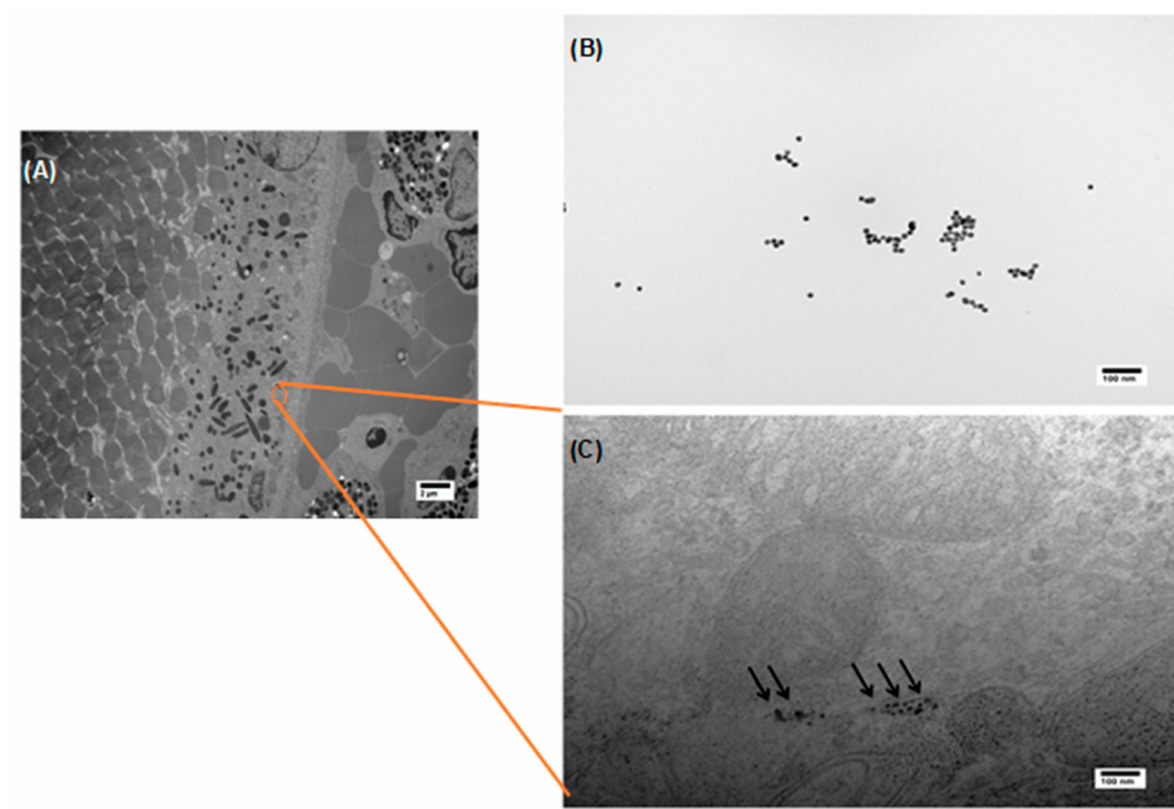
Figure 3. TEM images showing HA-AuNPs biodistributed in the RPE layer, 30 min following their instillation on the surface of a mouse eye. ( A ) Micrograph of a cross-section through the choroid, RPE, and the retina of mouse treated with